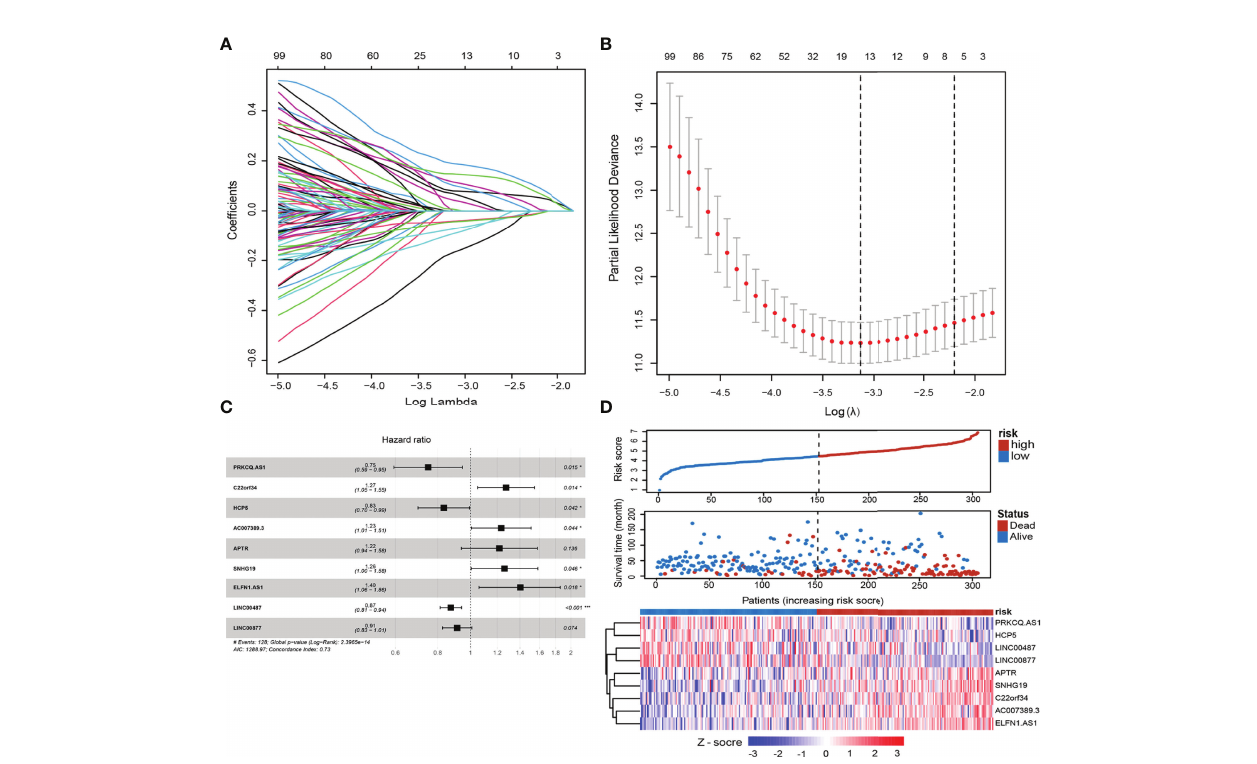
FIGURE 2 | Construction of the epigenetic-related lncRNA signature (ELncSig). (A) Thirteen epigenetic-related lncRNAs were selected by LASSO Cox regression analysis. (B) Cross-validation for tuning parameter selection in the proportional hazards model. (C) A forest map showing 9 lncRNAs identi fi ed by the stepwise method. (D) Risk score distribution, survival status, and lncRNA expression of DLBCL patients in high- and low-risk groups classi fi ed by the 9-ELncRNA signature in the training